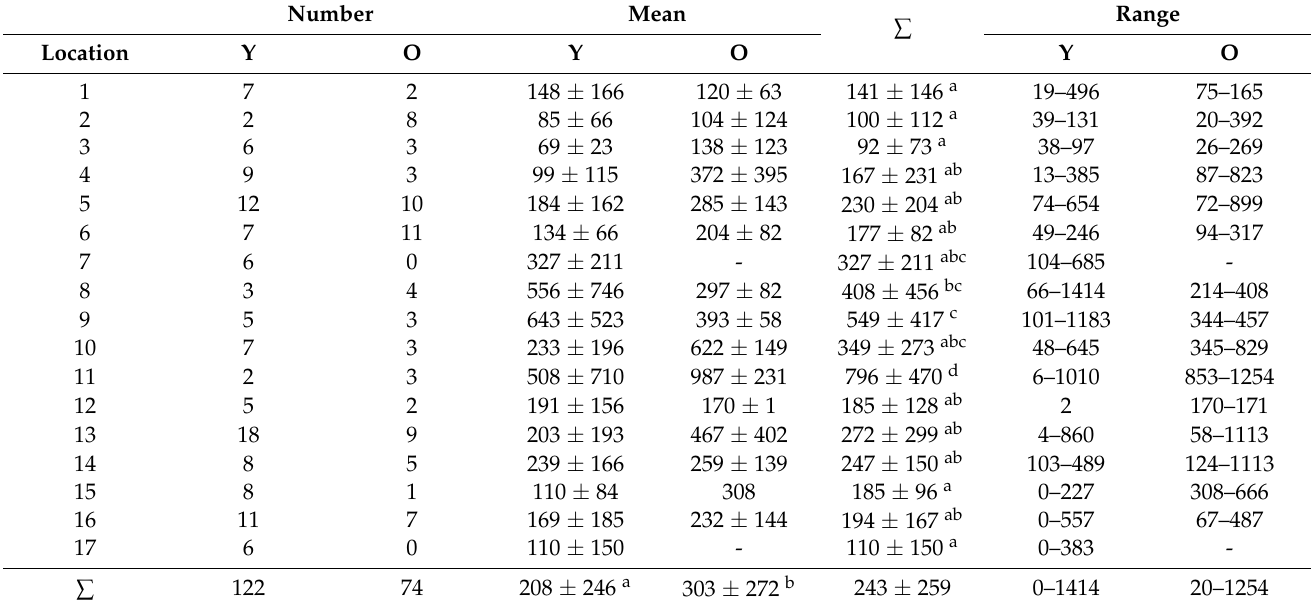
Table 2. The occurrence of cadmium in samples of hare liver from 17 different locations in the region of Vojvodina ( µ g/kg of fresh weight),